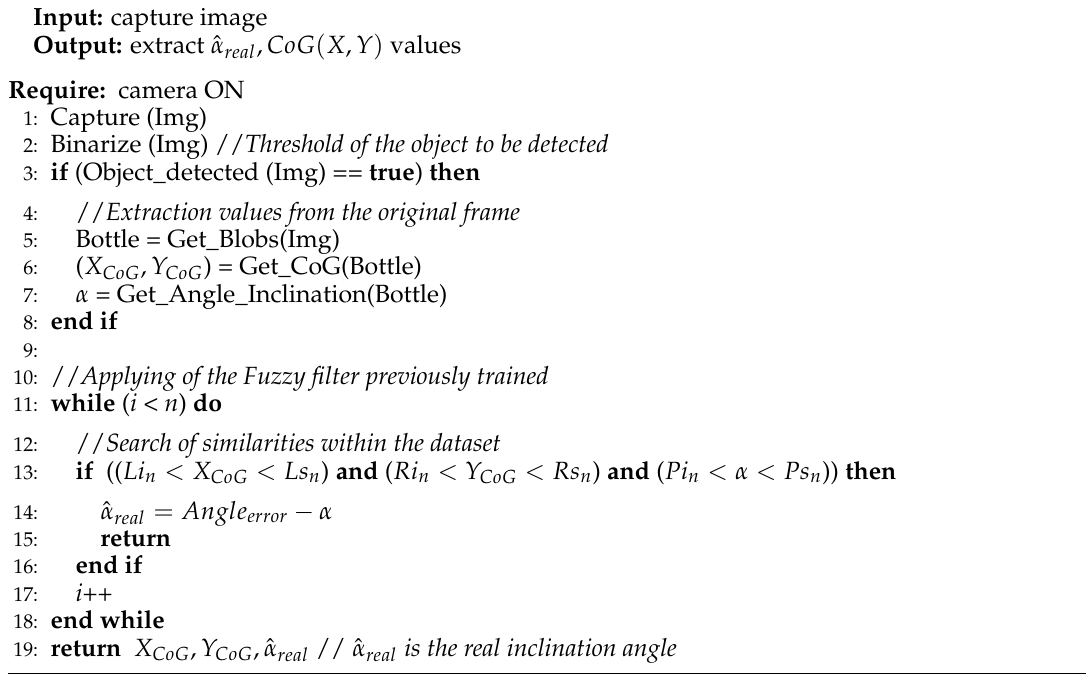
Algorithm 2 Data acquisition by using a Neuro-Fuzzy filter. (Figure 6 bottom).